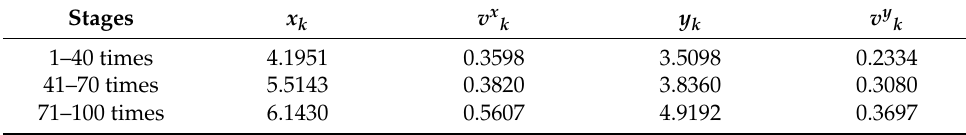
Table 2. RMSE with AHUKF at different stages.